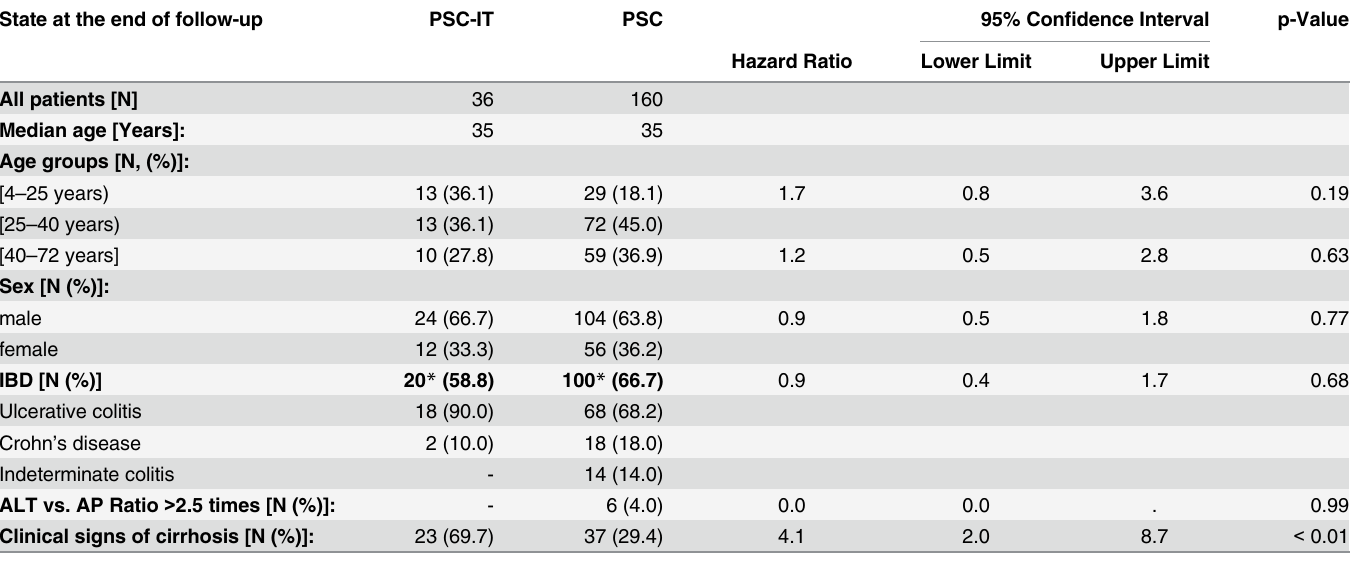
Table 1. Univariate analysis of potential risk factors for IT as first event after UDCA prescription (using Cox' model) at first presentation. State at the end of follow-up